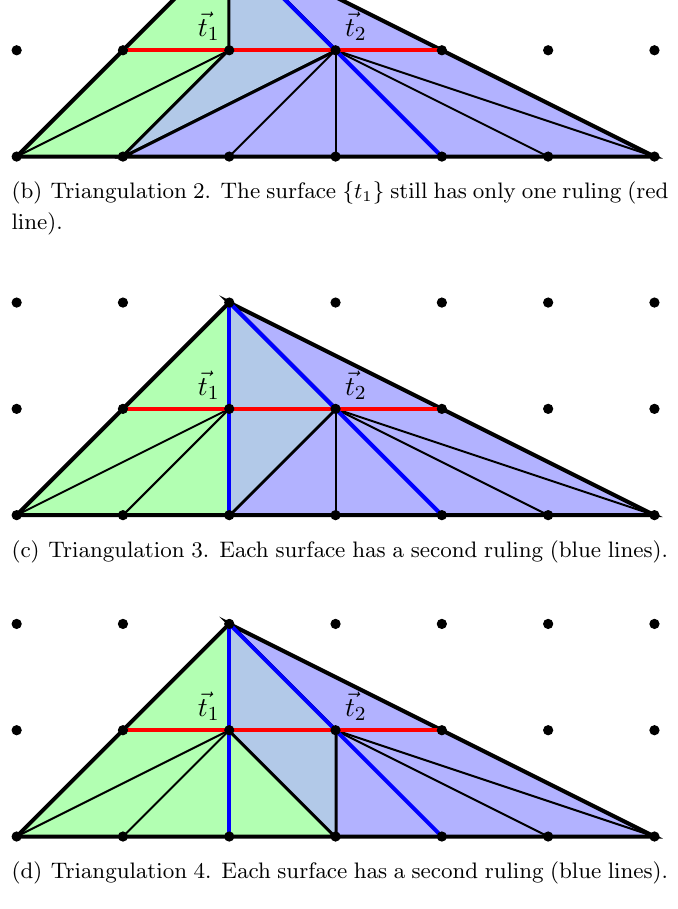
Figure 7 . The four inequivalent triangulations of the full facet of the top over E on the triangulation, each of the two surfaces f t i g can have a di(cid:11)erent ruling in addition to the one which glues them together along sections. In the case where both surfaces are ruled separately (blue lines), the corresponding blow downs produces an su (2) (cid:2) su (2) quiver.